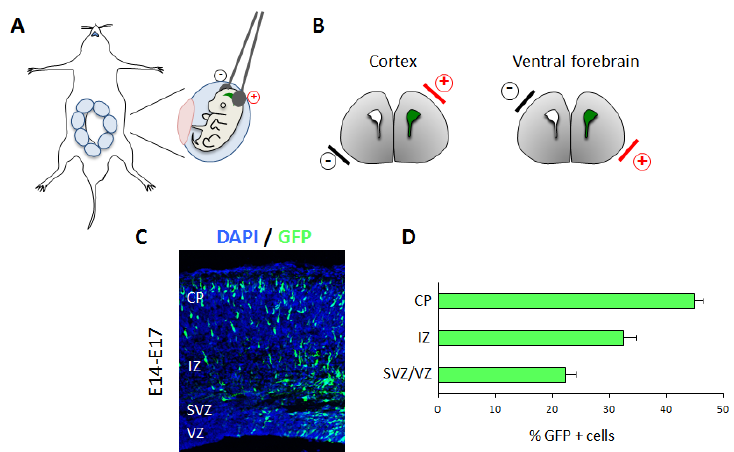
Figure 4. ( A , B ) Schematic representation of in utero electroporation. Uteri are exposed from the abdominal cavity and embryonic brains are electroporated. The position of the electrodes determines the electroporated area, as indicated in ( B ). ( C ) Representative results of radial migration analysis. Section of E17 embryonic cortex electroporated with GFP vector at E14. Nuclei are counterstained in blue. ( D ) Quantification graph showing the distribution of GFP-positive cells in different zones of the cortex (VZ/SVZ, IZ and CP). The majority of GFP positive cells have migrated to the cortical plate. VZ: ventricular zone; SVZ: subventricular zone; IZ: intermediate zone; CP: cortical plate